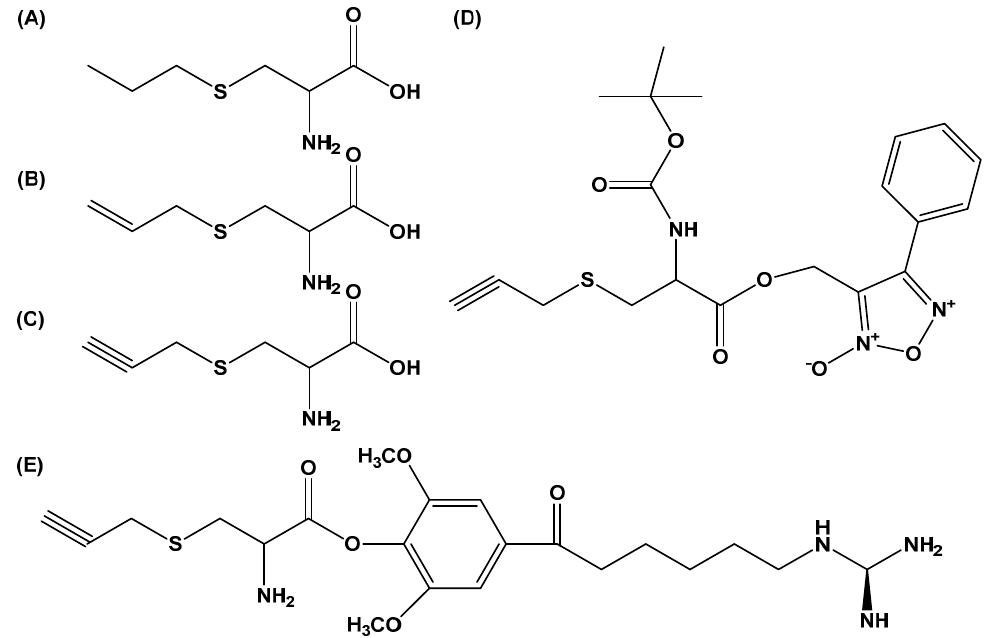
Figure 6. ( A ) S -propylcysteine, ( B ) S -allylcysteine, ( C ) S -propargylcysteine, three widely characterized cysteine analogs. ( D ) Dual H 2 S and NO hybrid molecule ZYZ803. ( E ) Leonurine–SPRC conjugate, 3,5-dimethoxy-4-(2-amino-3-prop-2-ynylsulfanyl-propionyl)-benzoic acid 4-guanidino-butyl ester. This molecule has cardioprotective effect against hypoxia-induced neonatal rat ventricular myocyte damage [80].